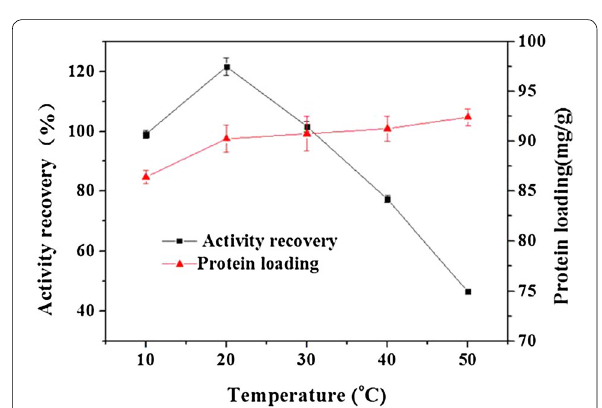
Fig. 6 Effects of immobilization temperature on activity recovery and enzyme loading of immobilized GOx